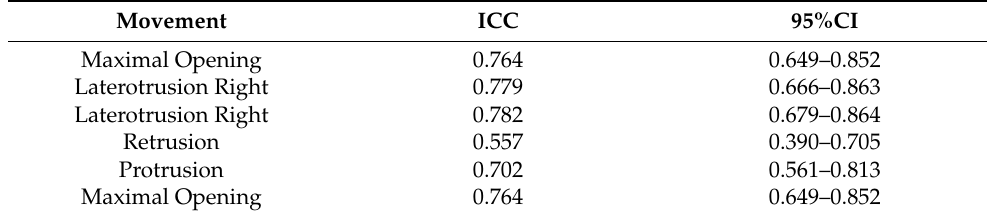
Table 3. ICC estimates for inter-rater reliability of each variable and their 95% confidence